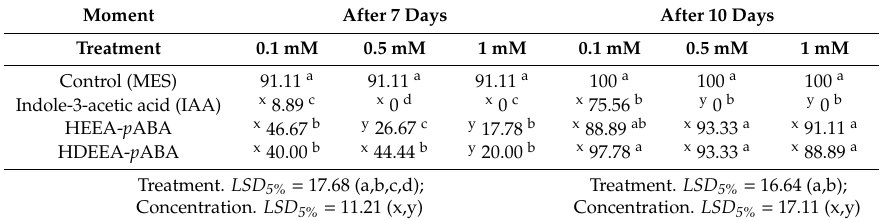
Table 3. The influence of treatments on tomato seed germination (tomato cultivar (cv.) Tomtim). Moment After 7 Days After 10 Days Treatment 0.1 mM 0.5 mM 1 mM 0.1 mM 0.5 mM 1 mM Control (MES) 91.11 a 91.11 a Indole-3-acetic acid